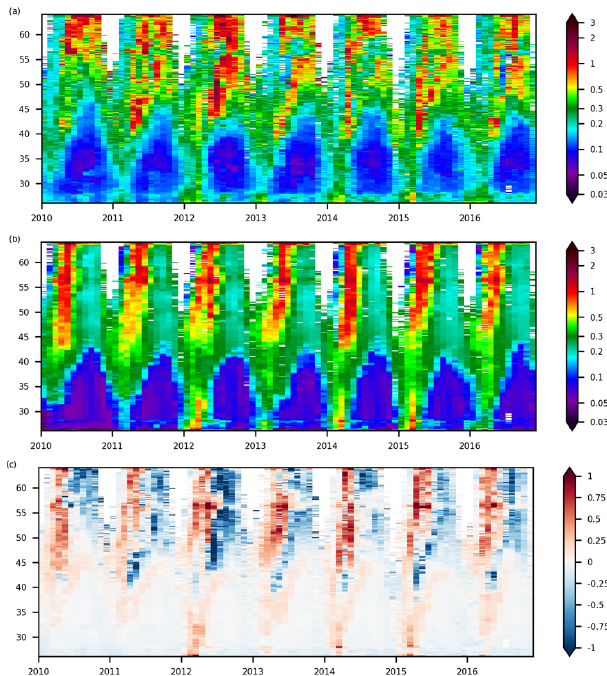
Figure 3. Hovmöller diagram for sea surface Chl a at 15 ◦ W be- tween 2010 and 2016. (a) ESA OC-CCI product, (b) IBI36 and (c) bias of Chl a (model − obs), all expressed in mgChlm − 3 . Monthly fields between 2010 and 2016 are